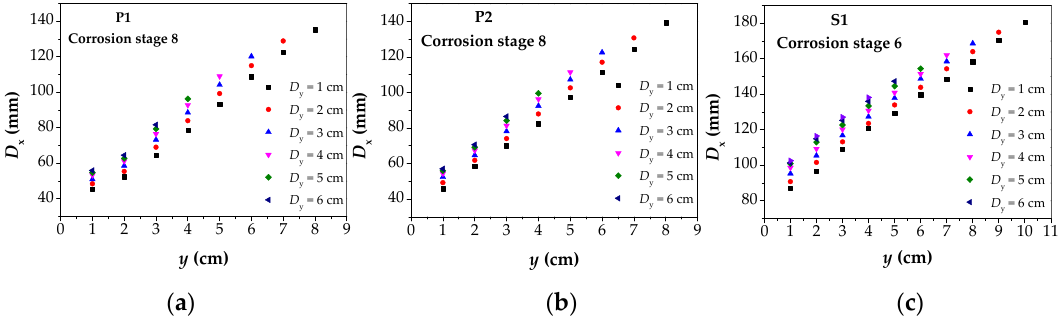
Figure 18. The obtained values of D x of the three specimens in a corrosion stage: ( a ) the values of D x of P1 in corrosion stage 8; ( b ) the values of D x of P2 in corrosion stage 8; ( c ) the values of D x of S1 in corrosion stage 6. P1: the parallel wire strand made of seven steel wires; P2: the parallel wire strand made of 19 steel wires; S1: the steel strand; D x : the intersecting point distance between curves of magnetic flux component of x direction at different lift off heights.